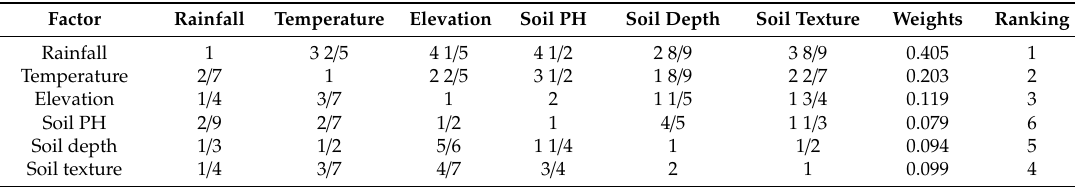
Table 5. Pairwise comparison matrix in the analytical hierarchy process (AHP) based on expert opinions.